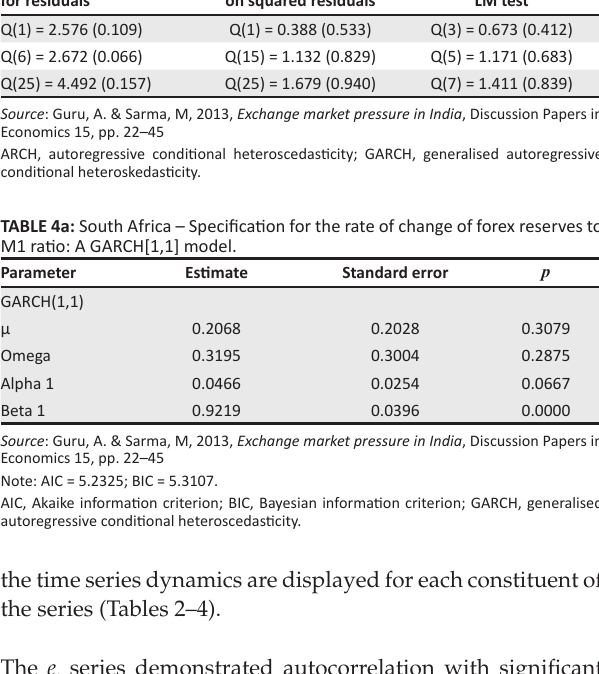
TABLE 3b: South Africa – Specification for the rate of change of interest rate: A [AR(1)- GARCH(1,1)] model. Weighted Ljung–Box test for residuals